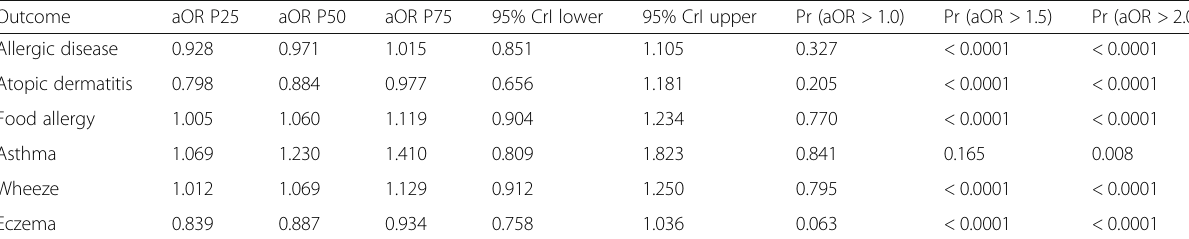
Table 6 Results of Bayesian multivariable logistic regression for allergic features associated with initial rotavirus vaccine only compared with initial BCG only, in the JECS birth cohort for complete cases (RQ3) Outcome aOR